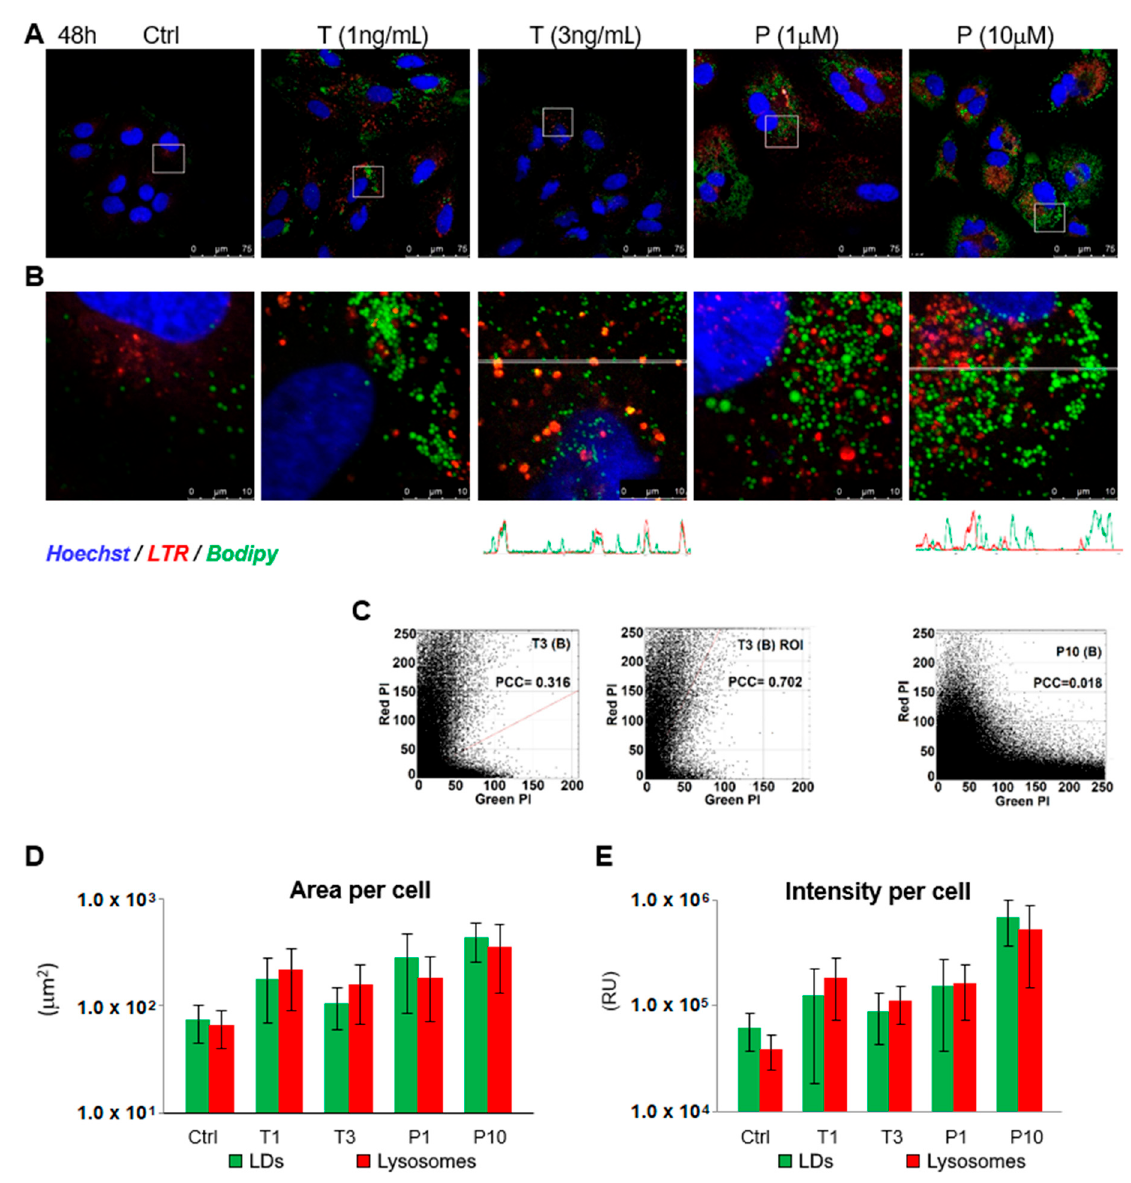
Figure 3. TGF- β 1 and palbociclib cause accumulation of lipid droplets in hepatoma cells. ( A , B ) Confocal microscope images of Hoechst- , LTR- , and Bodipy -stained Huh7-luc/neo cells treated with indicated concentrations of TGF- β 1 (T) and palbociclib (P) for 48 h and colocalization of Bodipy (LDs) and LTR (lysosomes) fluorescence signal indicated by red-green-blue (RGB) band profiles shown below the corresponding image. ( C ) Scatterplots of green and red pixel intensities (PI) of the cells shown in T3 ( B ) and P10 ( B ) and scatterplot in the region of interest (ROI) containing lysosomes in cells shown in T3 ( B ); PCC—Pearson’s correlation coefficient. ( D ) Area ( µ m 2 per cell) occupied by green label (LDs) and red label (lysosomes) in cells shown in Figure 3A and ( E ) intensity of green (LDs) and red (lysosomes) fluorochromes; emission per cell was calculated as the sum of intensities (0–255) of all green and red pixels in a cell and expressed as relative units (RU). The area of 1 pixel is 0.0574 μ m 2 .